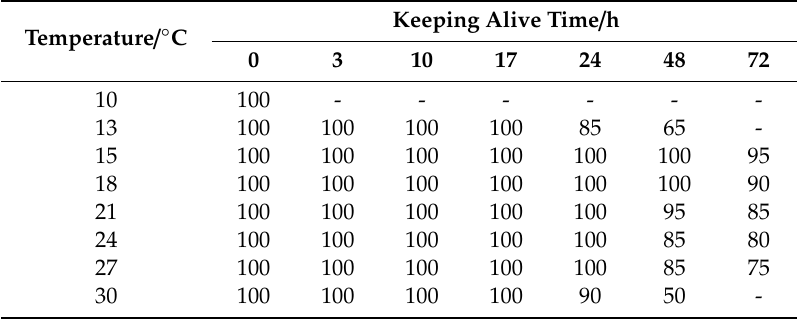
Table 3. Survival rate of tiger grouper at di ff erent temperatures and survival time (%). Temperature / ◦